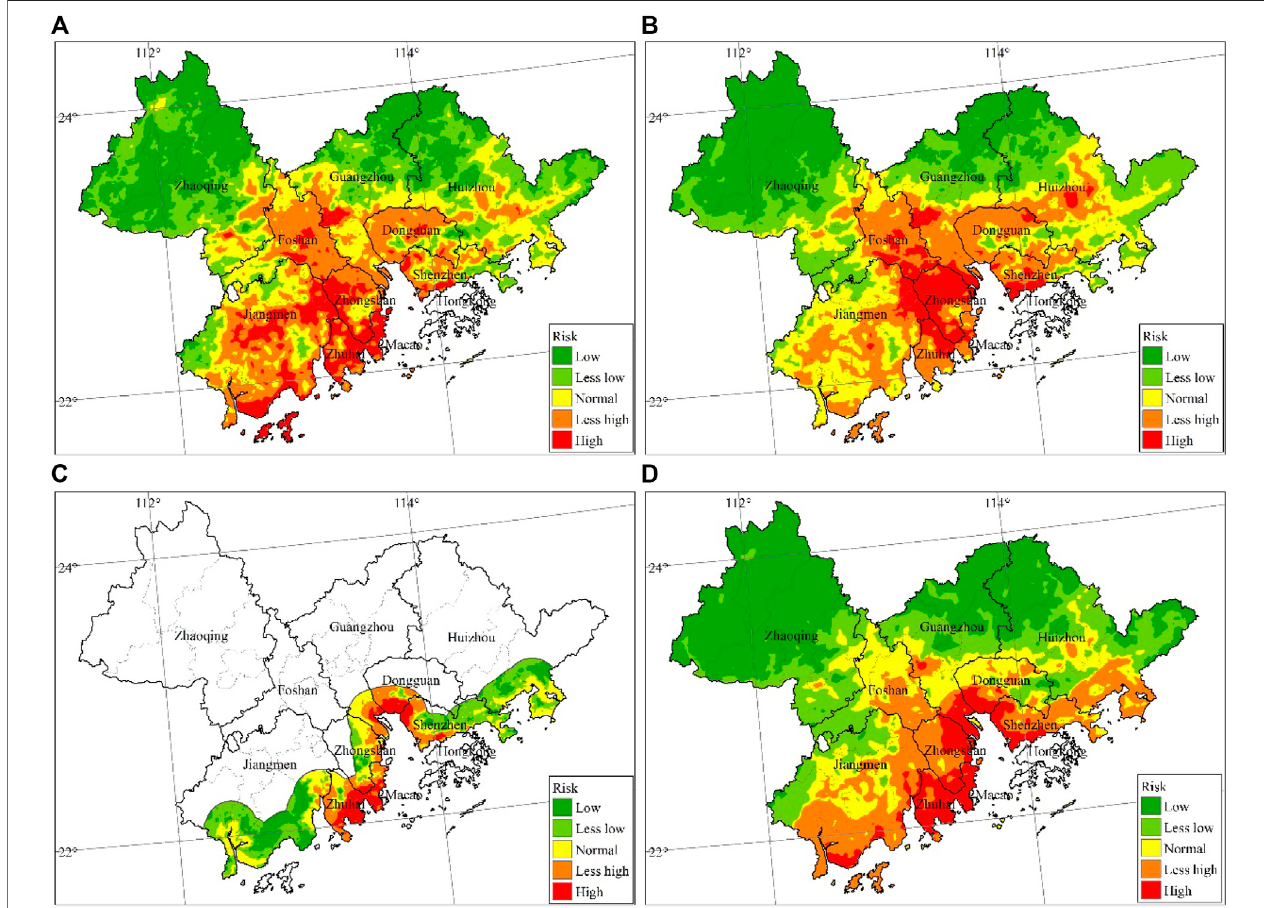
FIGURE 9 | Risk distributions of (A) typhoon – gale, (B) typhoon – rainstorm, (C) typhoon – storm surge disaster chains, and (D) typhoon comprehensive risk in the GBA from 2009 to 2020.